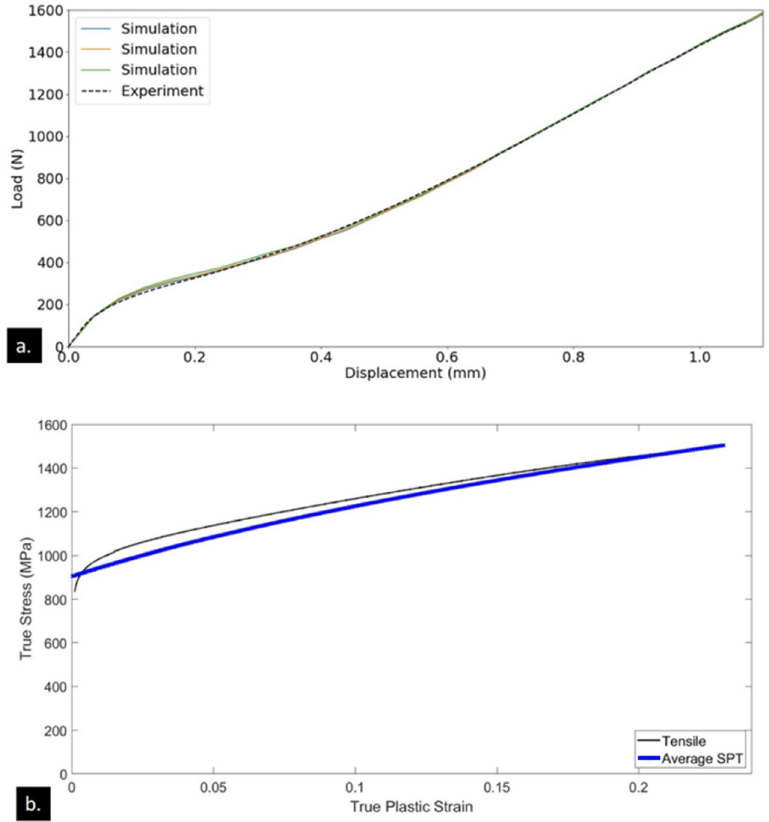
Figure 8. ( a ) Comparison of the measured SPT load-displacement curve on Sample number 6 with the three closest FE-predicted curves (i.e., exhibiting the lowest mean absolute error with respect to the measurement). ( b ) The stress-strain curve corresponding to the average K , ε 0 , and n values of the best fit solutions in ( a ) compared against the corresponding UTT response for the same